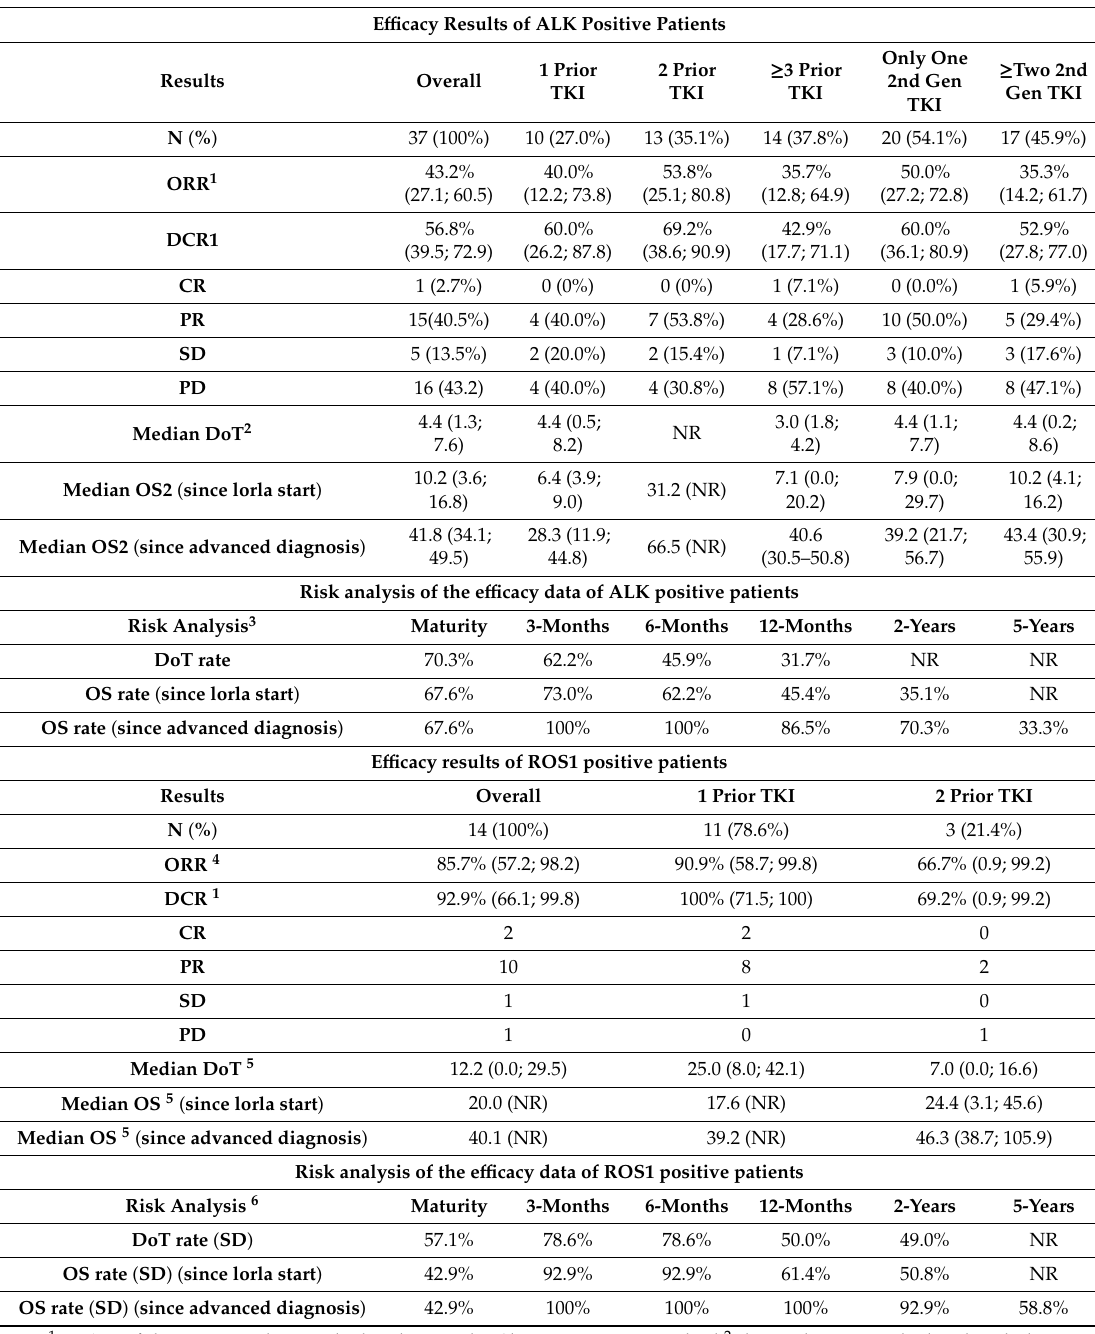
Table 2. E ffi cacy results of ALK and ROS positive patients including risk analysis E ffi cacy Results of ALK Positive